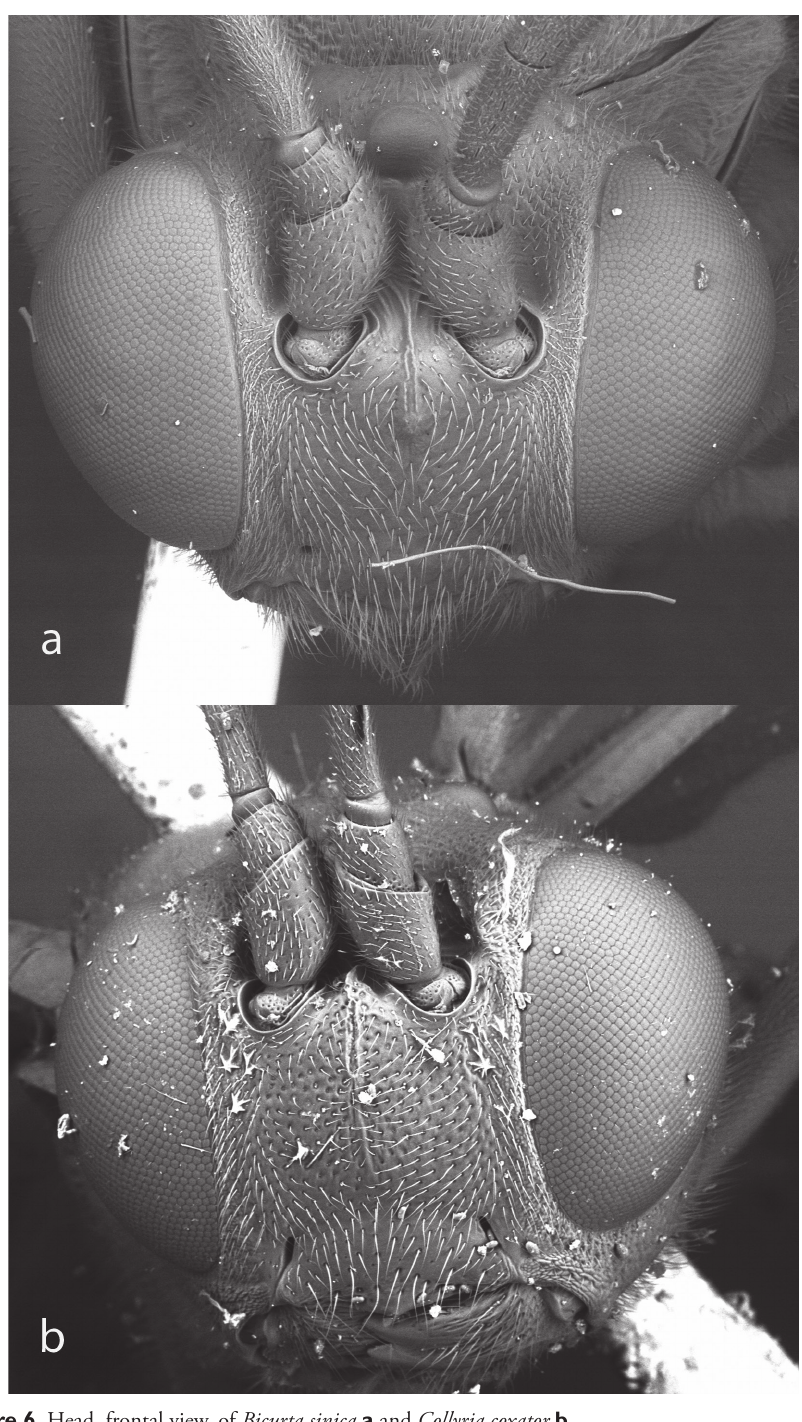
Figure 6 . Head, frontal view, of Bicurta sinica a and Collyria coxator b